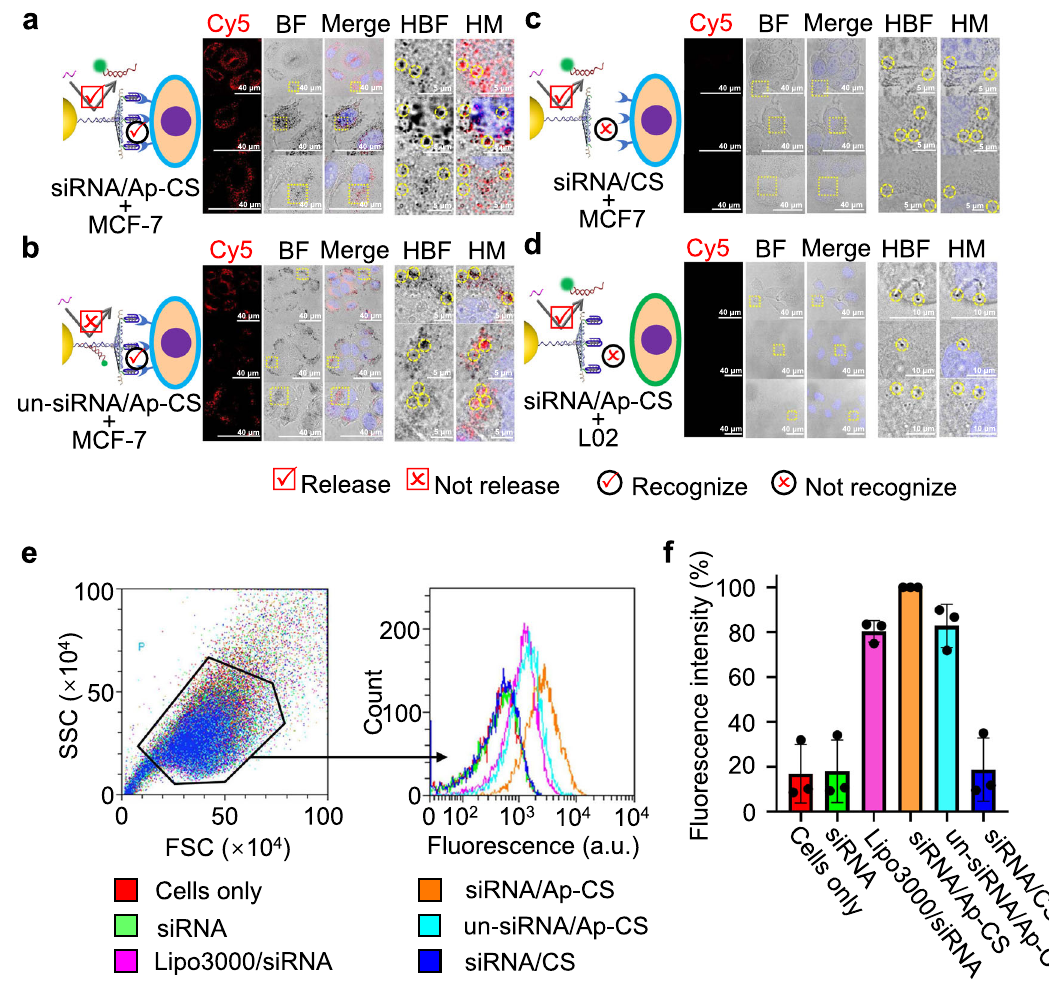
Fig. 5 Colocalization assay of siRNA (red fl uorescence) and AuNPs (black dot) within target cancer cells. MCF-7 cells were separately incubated with releasable siPlk1/Ap-CS ( a ), unreleasable siPlk1 (un-siPlk1)/Ap-CS ( b ) and releasable siPlk1/CS without aptamer ( c ) for 4 h. d is the same as a but L02 cells were instead used. HM in the right half part is the high-resolution image of the area in yellow dotted box indicated in the section of Merge, while HBF is the high-resolution image boxed in bright fi eld (BF). AuNPs in HM and HBF are highlighted by yellow dotted circles ( a – d ). The cell imaging experiments in a – d were conducted three times independently with similar results. e Flow cytometry analysis of MCF-7 cells treated with various formulations for 4 h. f The quantitative fl uorescence intensity of each sample in e . The error bar represents the standard deviation (SD). The measured data are expressed as the means± SD ( n =